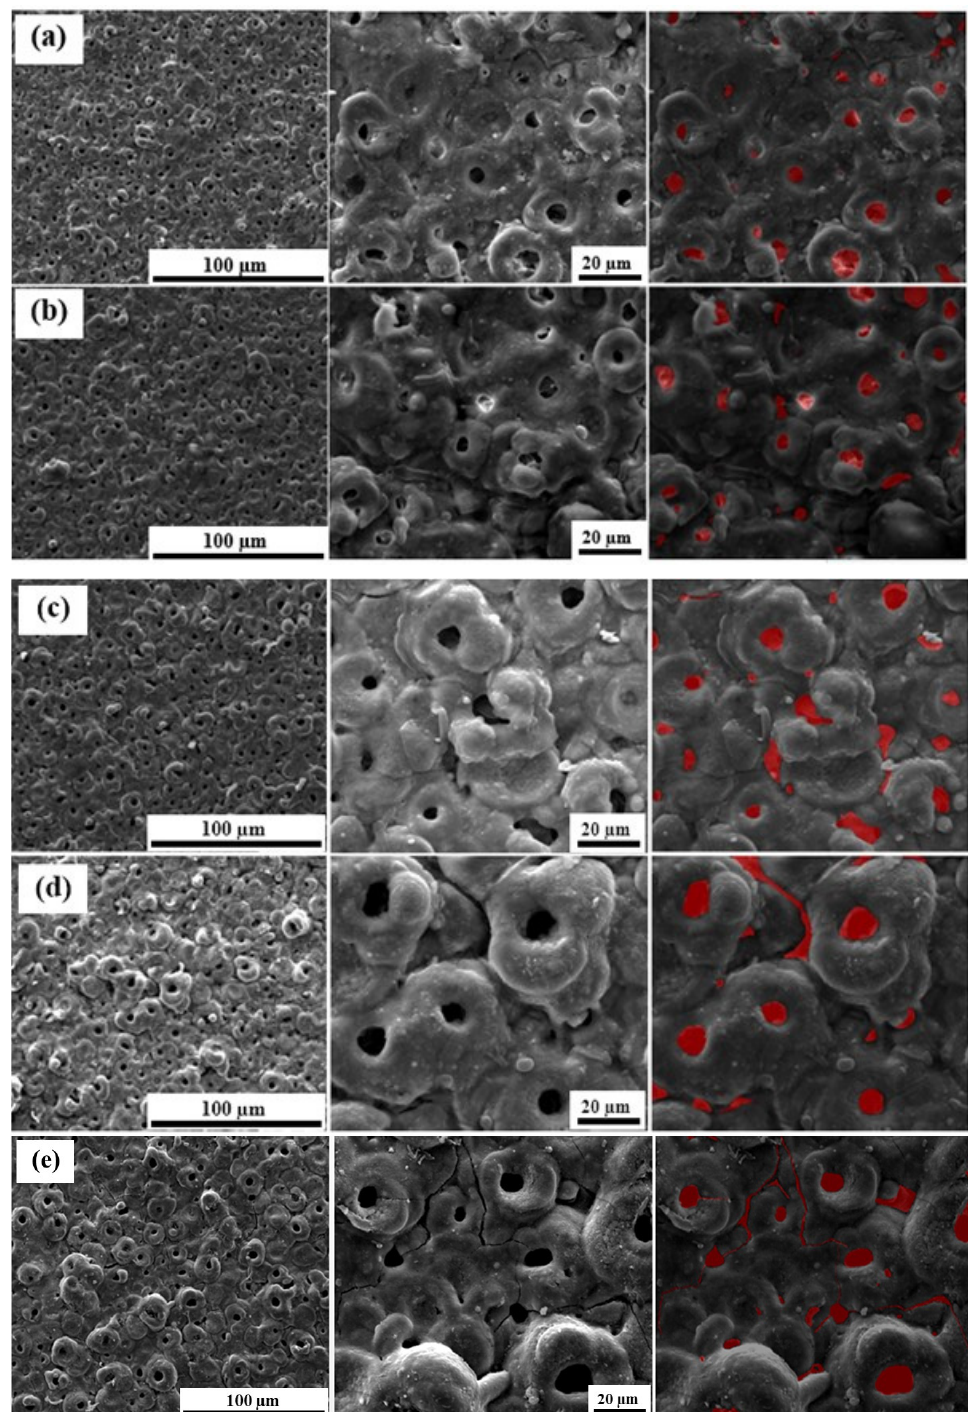
Figure 2. FE-SEM images of surface at various concentrations of TiO 2 : 0 ( a ), 1 ( b ), 2 ( c ), 3 ( d ), and 4 ( e ) g/L. The graphs of the average porosity and the average size of pores are shown in Figure 3.